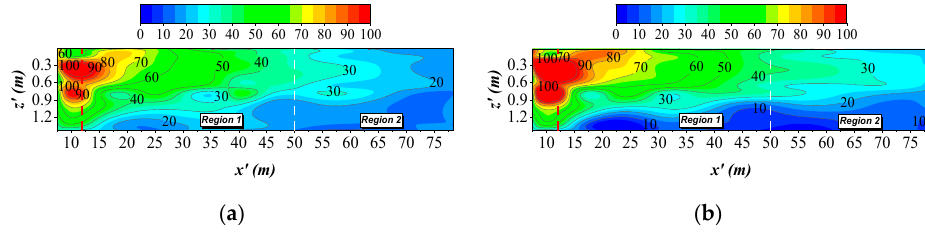
Figure 16. Temperature distribution of the hot gas layer in: ( a ) Test S01; ( b ) Test E02 (Unit: K).